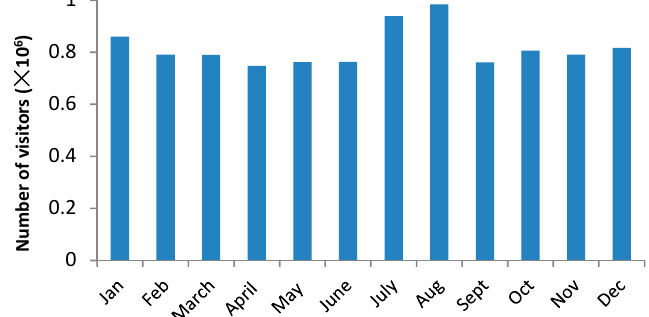
Figure 14. Monthly variation in visitors to Thailand in 2017 (Source: Department of Tourism, Thailand).